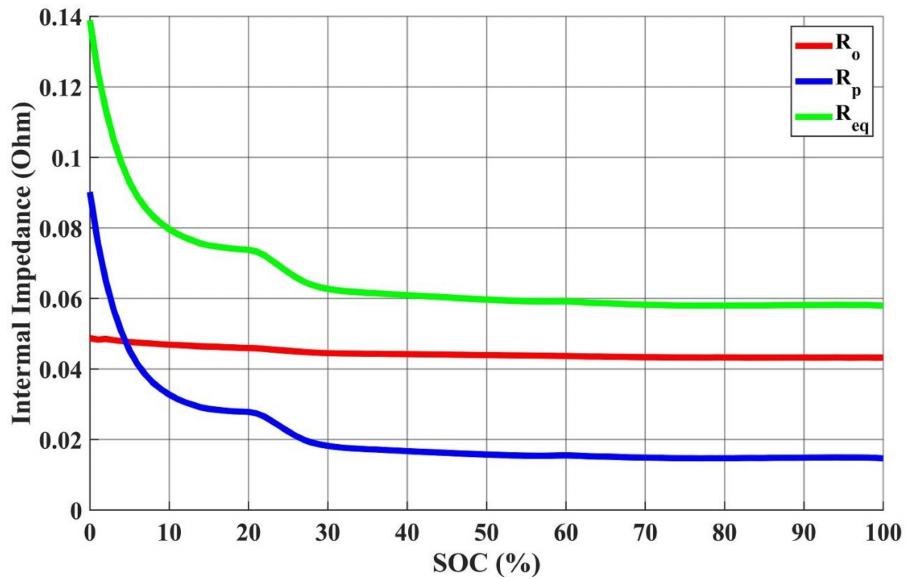
Figure 5. Relationship between series equivalent resistance ( R o ), shunt equivalent resistance ( R p ) and equivalent resistance ( R eq ) and state of charge